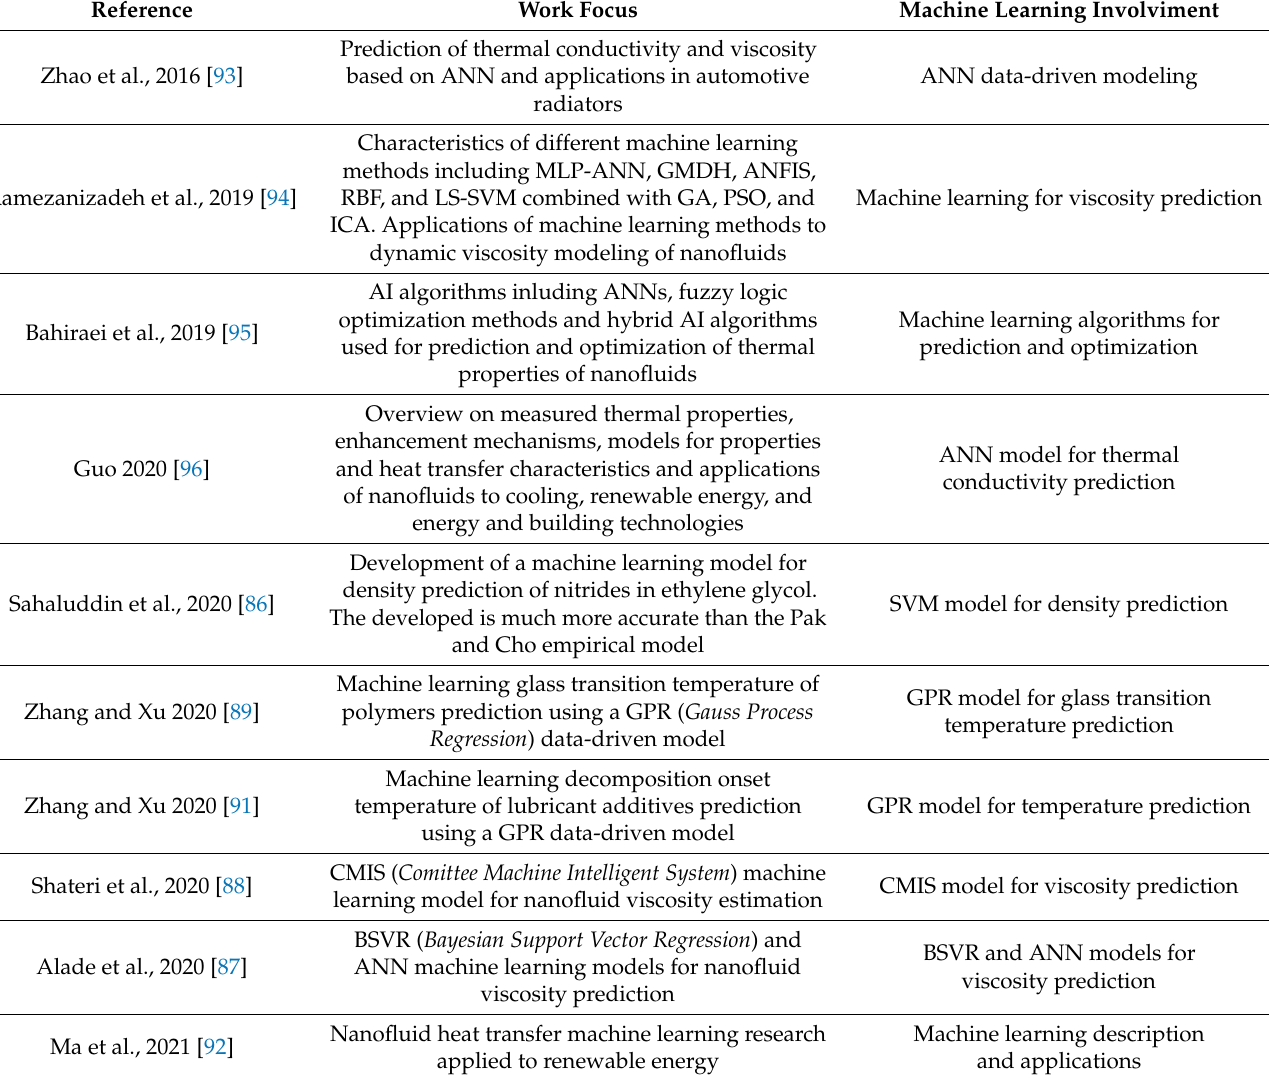
Table 2. Representative review papers on nanofluid heat transfer research using machine learning prediction